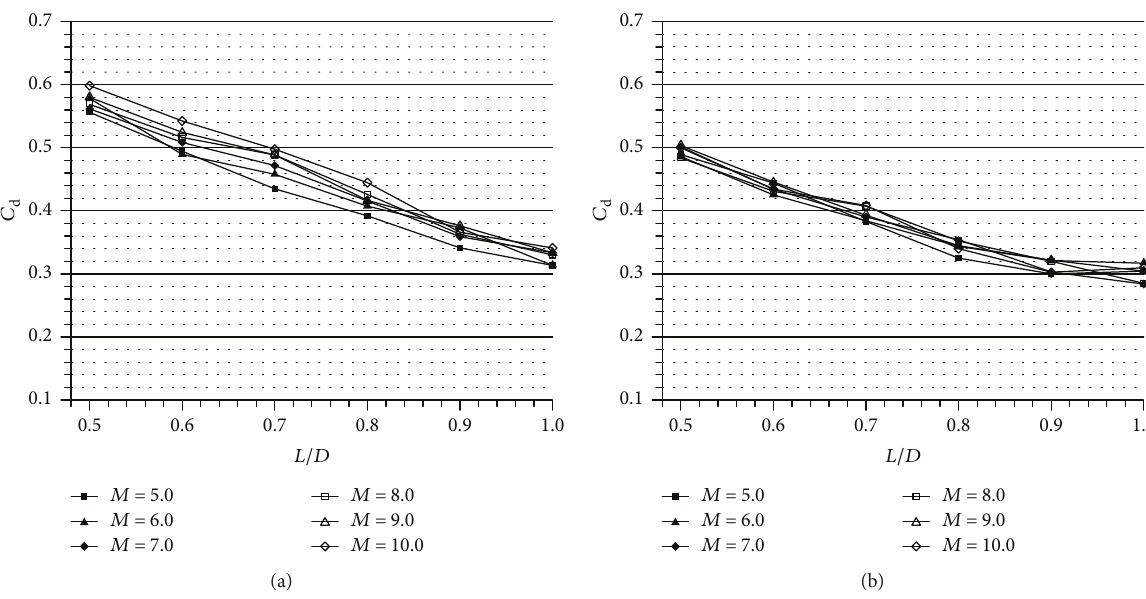
Figure 18: Drag coe ffi cients vary with the spike length increased: (a) the pure spiked blunt bodies; (b) the spiked blunt bodies with sonic sideward